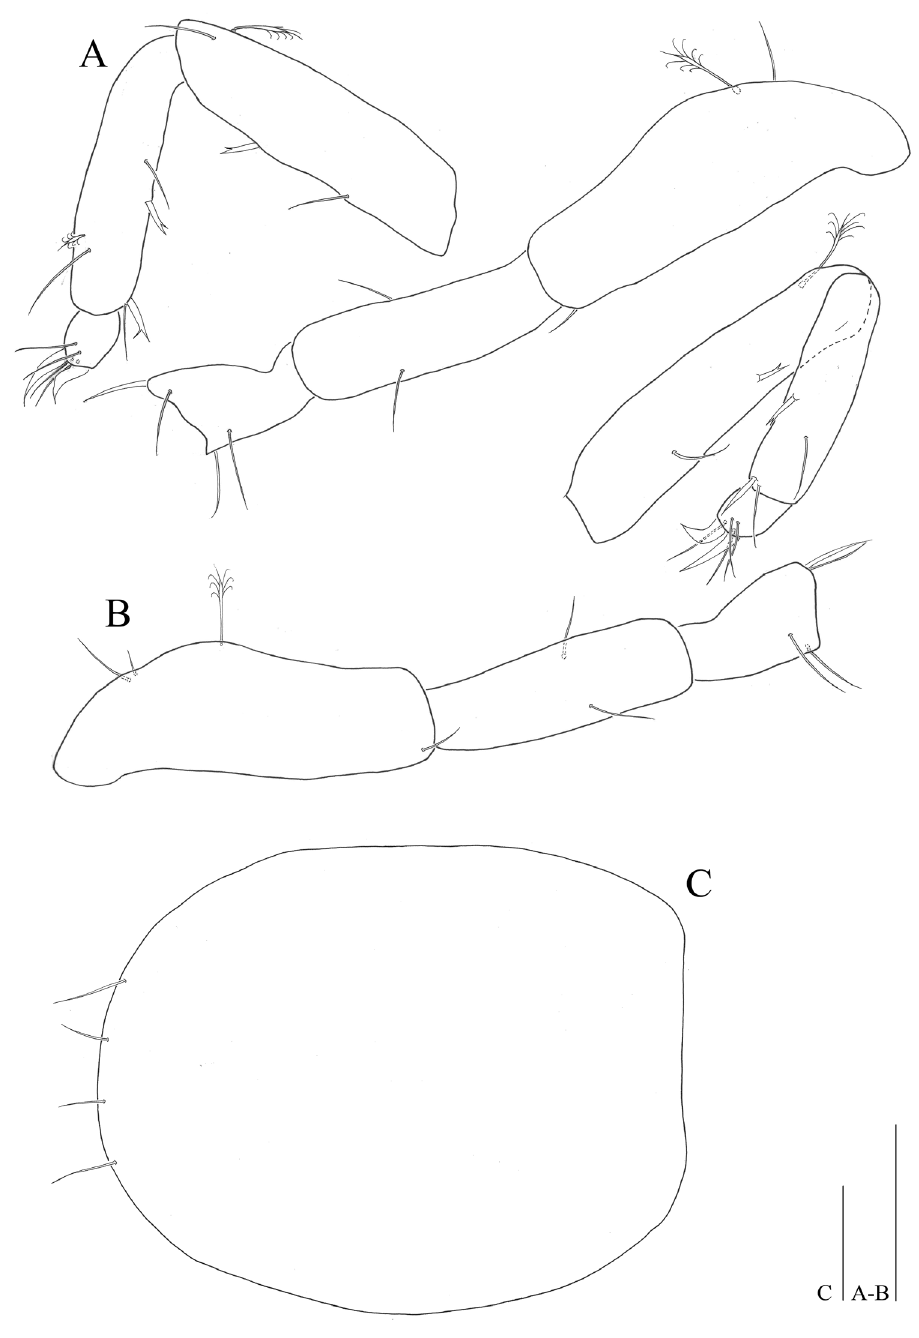
Figure 6. Microcharon tanakai sp. n., holotype, female. A pereopod 6, lateral B pereopod 7, lateral C operculum, dorsal. Scale bars